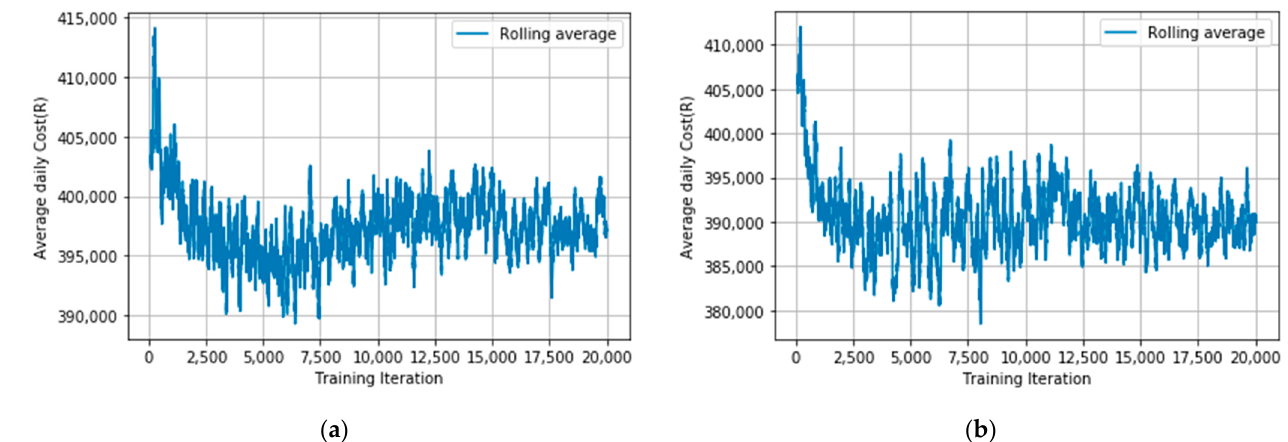
Figure 10. Daily operational cost against the number of episode; ( a ) trading algorithm ( b ) non-trading algorithm.